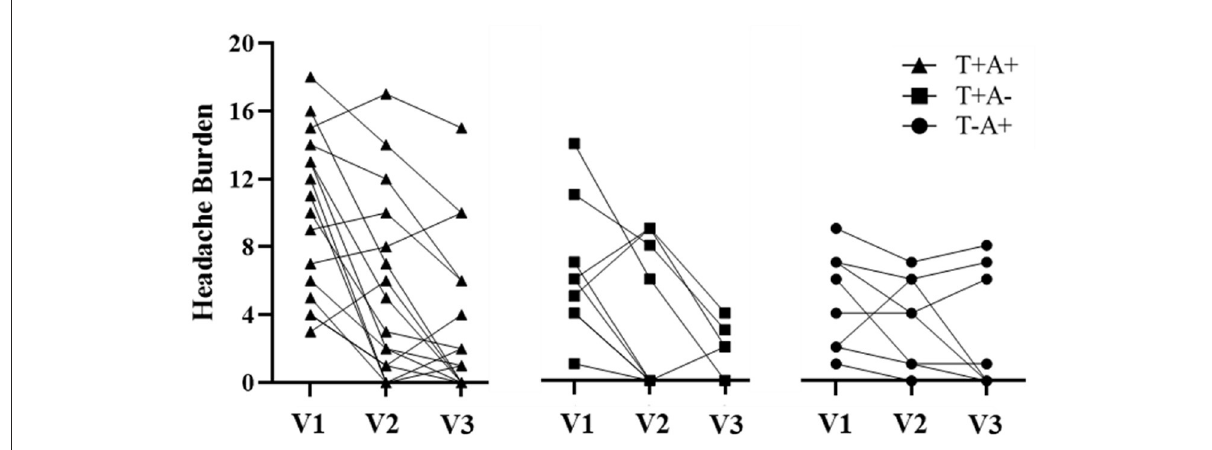
FIGURE3 Headache Burden among individual participant data within RAMP1 + CALCA genotype sub-groups across study visits (V1, V2, and V3, respectively).